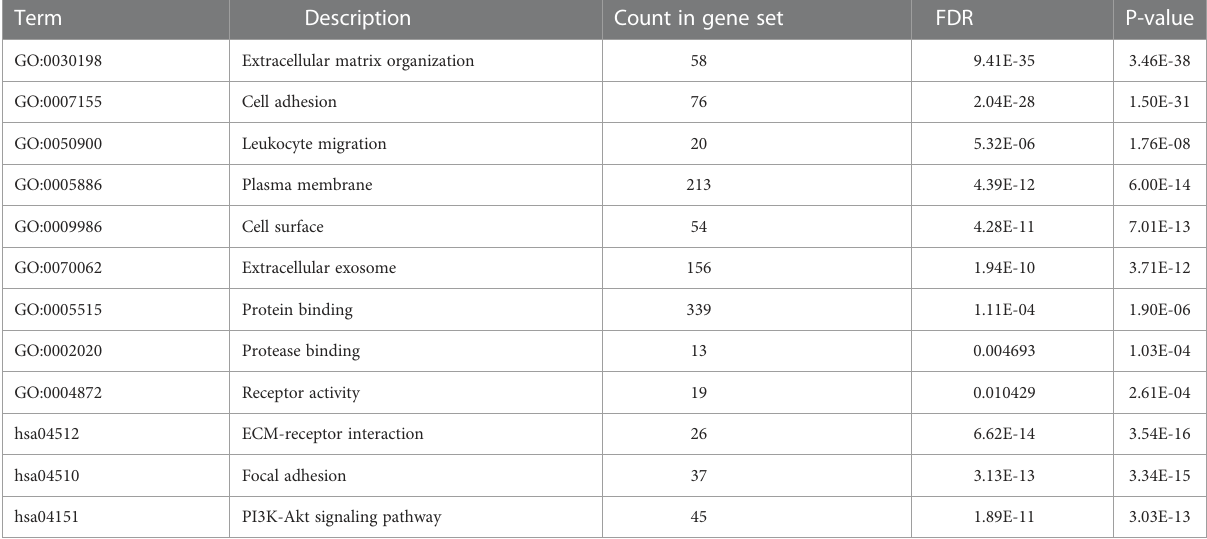
TABLE 3 GO and KEGG pathway enrichment analysis of DEGs in COAD samples.